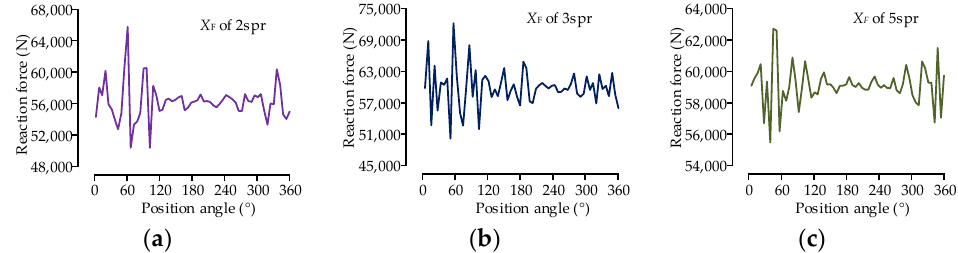
Figure 23. X F sequences in different cases. ( a ) X F sequences of 2 spr; ( b ) X F sequences of 3 spr; ( c ) X F sequences of 5 spr.